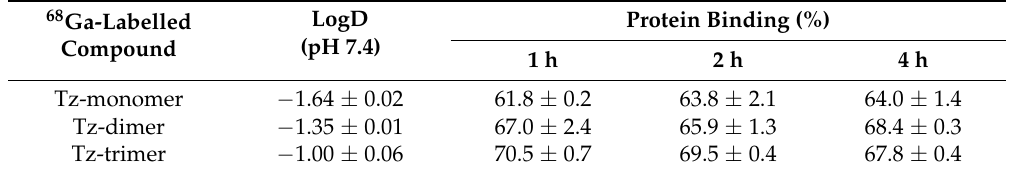
Data are presented as mean ± SD ( n =